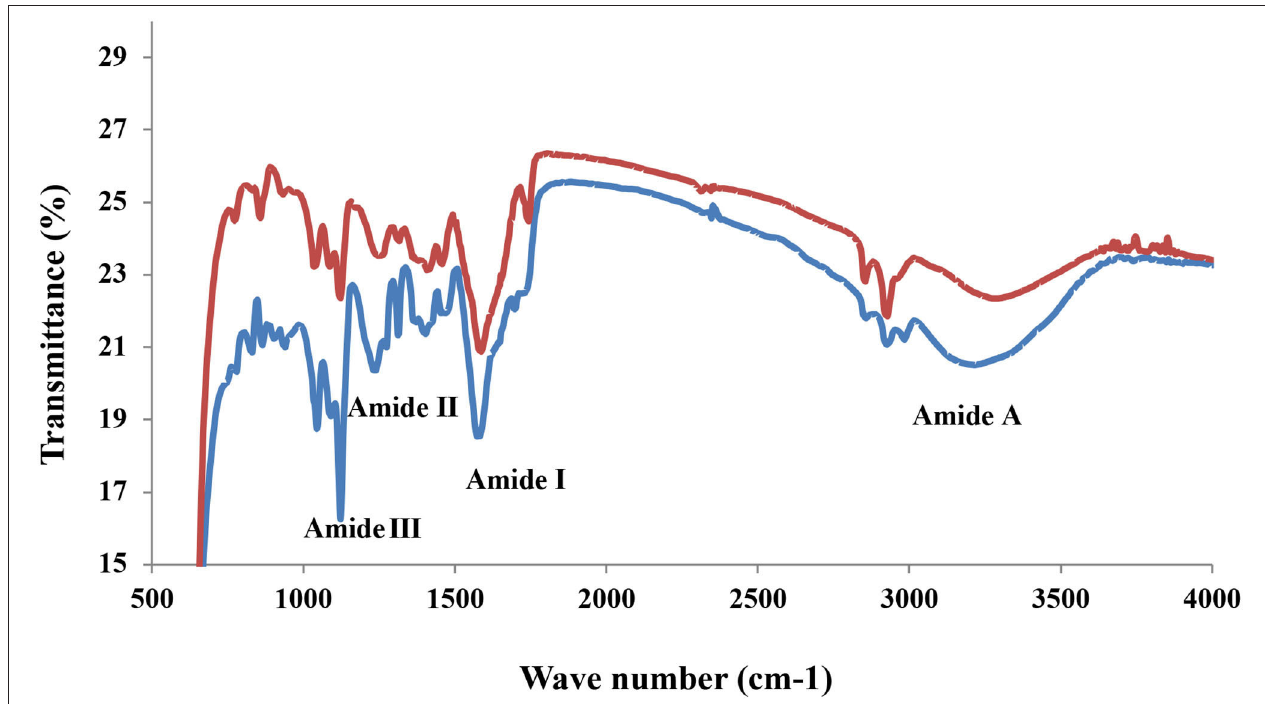
FIGURE 1 | FTIR spectra of FD ( – ) and HAD ( – )